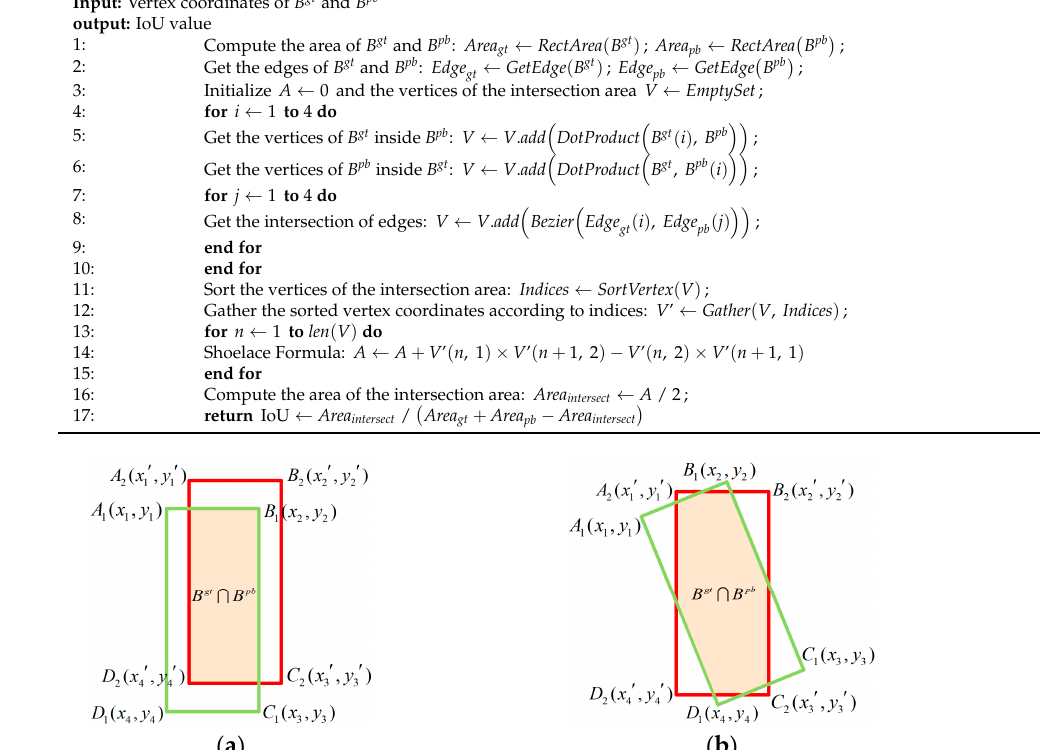
Algorithm 1: IoU computation for oriented bounding boxes